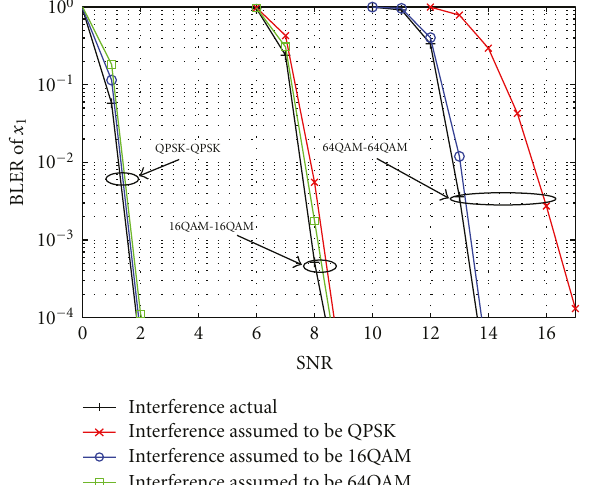
Figure 3: BLER versus SNR (dB) of the blind IA for three di ff erent constellation orders (e.g., QPSK-QPSK indicates that both x 1 and x 2 are QPSK). “Interference actual” implies the case once UE knows the constellation of interference ( x 2 ).